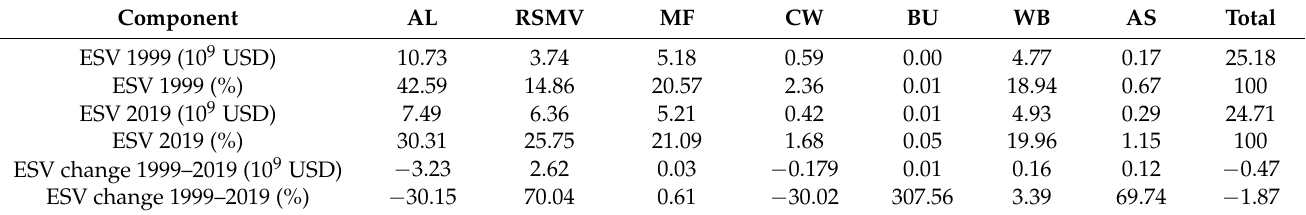
Table 4. ESV and their change rate by different land use type in CRB between 1999 and 2019. Component